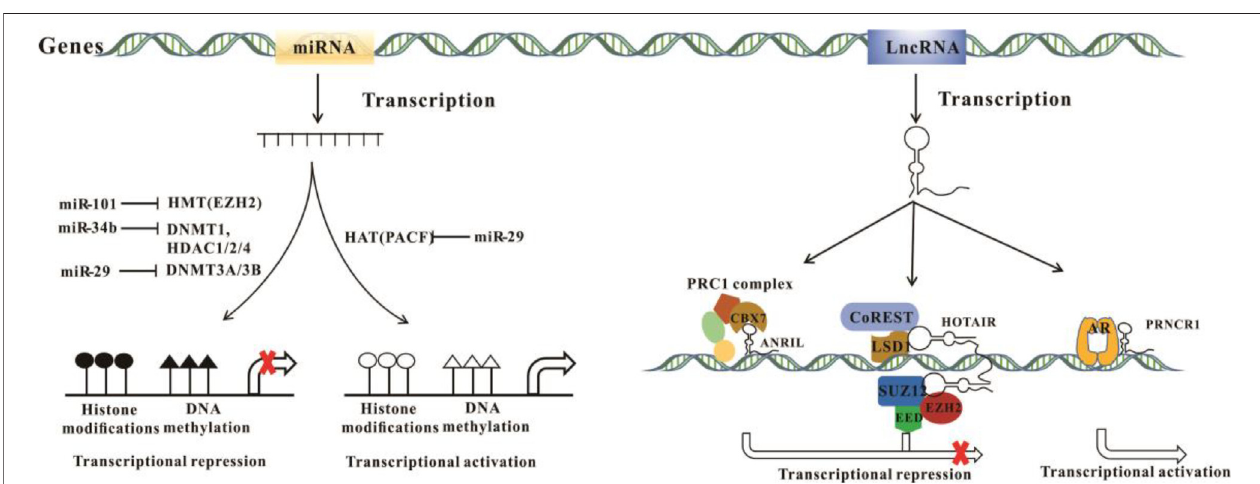
FIGURE 5 | The mechanisms of miRNA and lncRNA in epigenetic